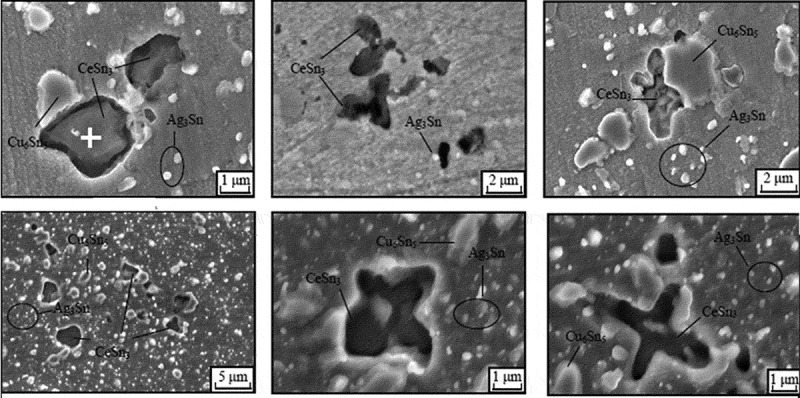
Reproduced by permission from Zhang et al., J Mech Eng. 2012;48(24):56–60.